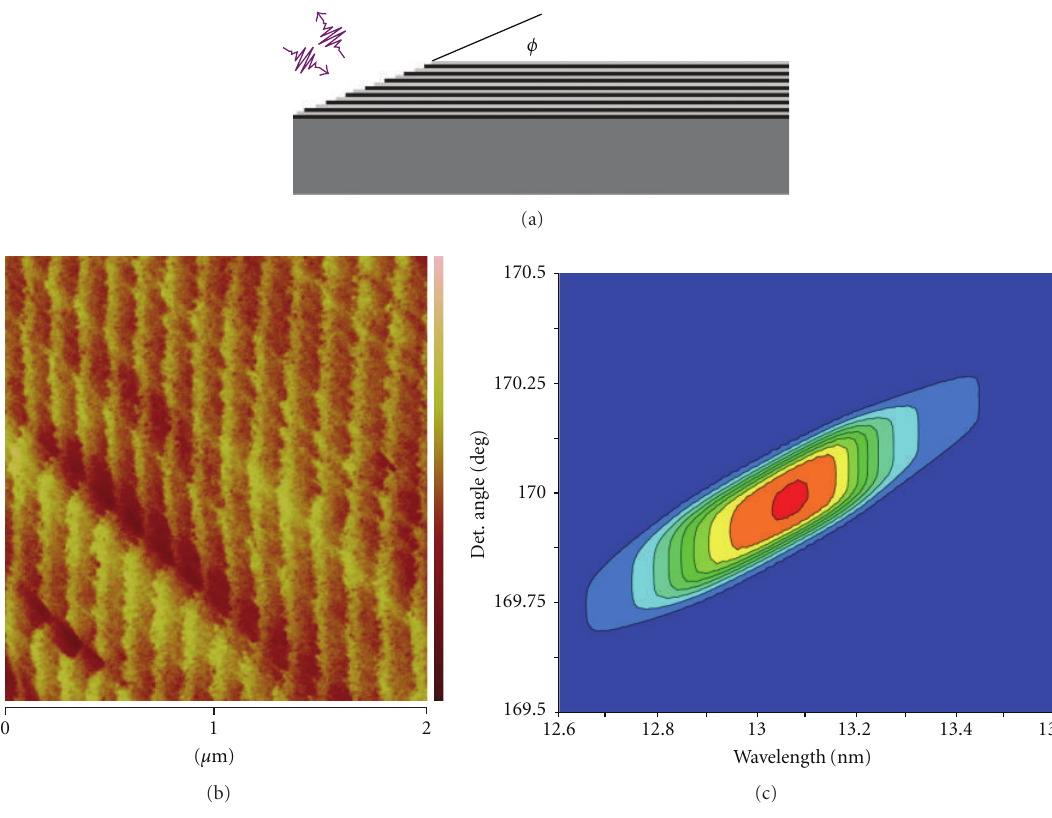
Figure 2: (a) A pictorial diagram of an asymmetrically cut multilayer with cut angle φ . (b) An atomic force micrograph of the surface of the asymmetrically cut multilayer. The periodic structure observed on the surface is due to the individual layers in the multilayer. These bilayers act as a high period grating. Also seen are striations left after polishing. As the asymmetrically cut multilayer is a volumetric grating, the surface imperfections have little e ff ect on the overall e ffi ciency and dispersion. (c) Reflectivity measurements of the dispersion from an asymmetrically cut multilayer conducted at beamline 6.3.2 at the Advanced Light Source. The multilayer cut angle φ was 5.4 degrees, and the measurement was conducted 5 degrees from normal of the top surface of the mirror. This particular asymmetrically cut multilayer corresponds to a grating d-spacing of ∼ 70 nm and had > 95% e ffi ciency into the 1st order.